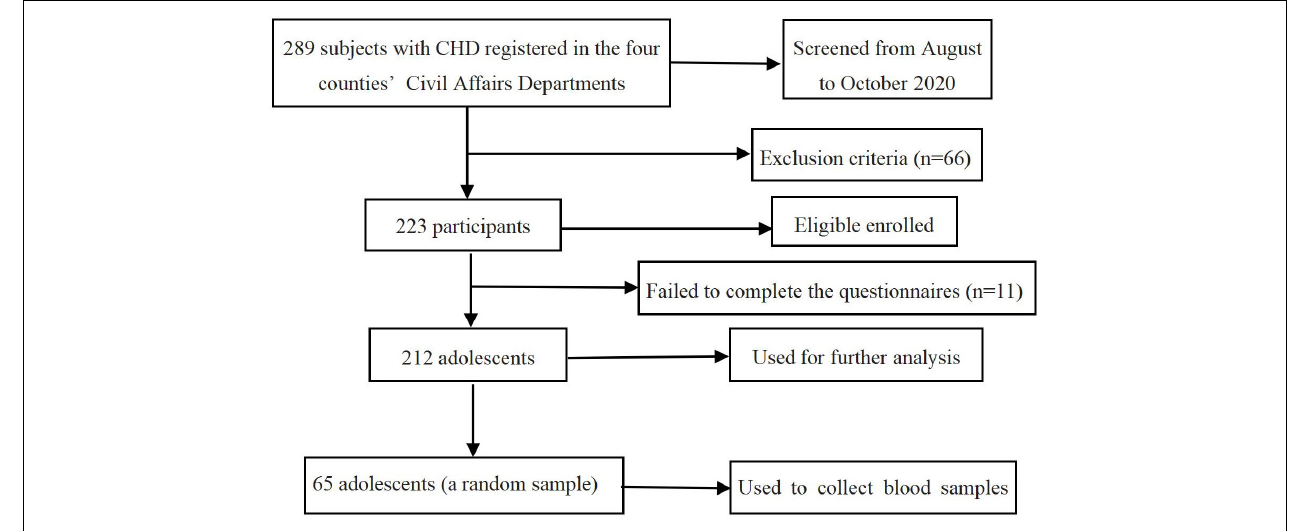
FIGURE 1 | Flowchart of subject enrollment and